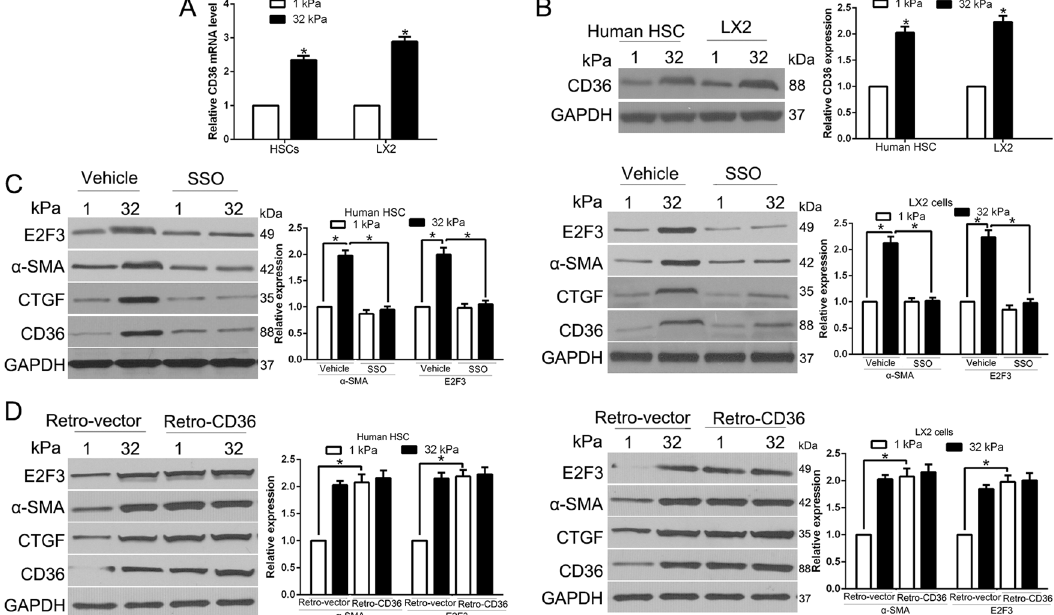
Fig. 3 Stiffness promoted E2F3 expression is mediated by CD36. A Quantitative real-time PCR after reverse transcription revealed that stiffness signi fi cantly increased CD36 mRNA level ( P > 0.05 by t -test, n = 6). B Primary human HSCs and LX2 cells on hydrogels were collected for WB. CD36 protein was increased by stiffness. * P < 0.05 by ANOVA, n = 3 for WB. C Primary human HSCs or LX2 cells on 1 or 32 kPa were treated with vehicle or CD36 inhibitor SSO. Stiffness-mediated E2F3 upregulation and HSC activation was abrogated by SSO. * P < 0.05 by ANOVA, n = 3 for WB. D Primary human HSCs or LX2 transduced with retroviruses encoding LacZ (Retro-vector) or CD36 (Retro-CD36) were seeded on 1 or 32 kPa for WB. CD36 led to HSC activation, E2F3 upregulation in HSCs on 1 kPa. * P < 0.05 by ANOVA, n = 3